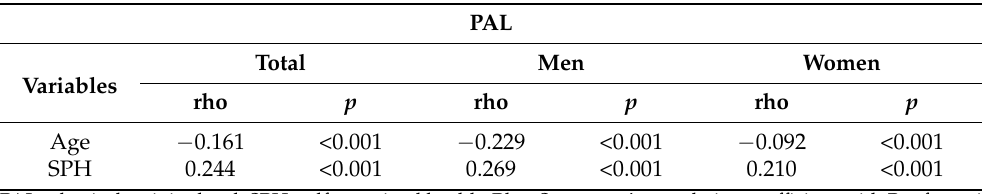
Table 5. Associations between the physical activity level, age, and self-perceived health in the Spanish population through the ENSE 2017.